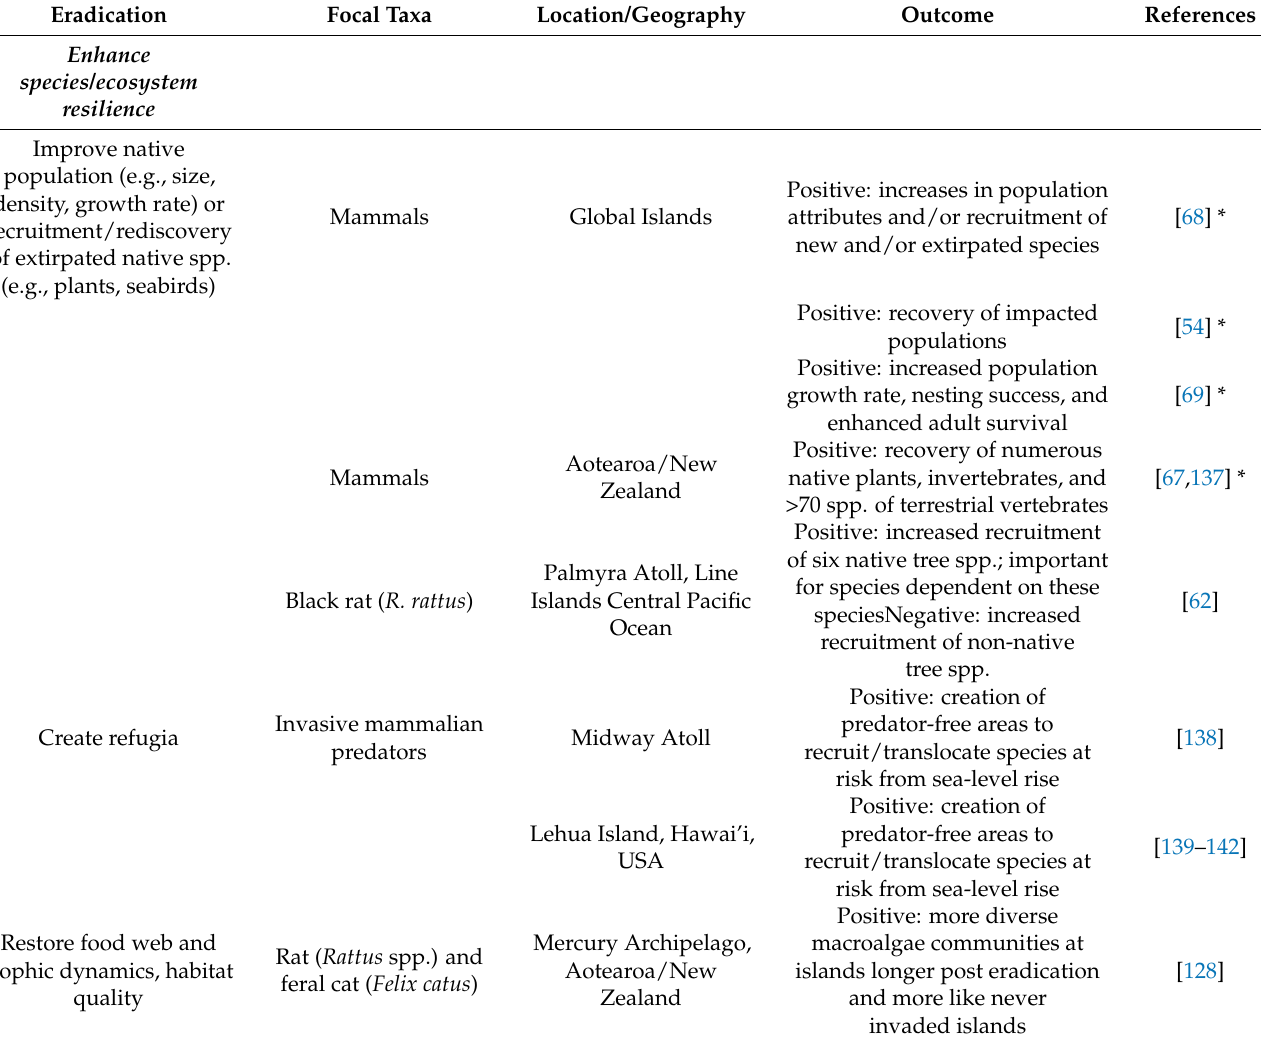
Table 3. Summary of evidence provided in the text that eradicating invasive mammals from islands may benefit climate change adaptation/resilience to or mitigation of climate change. This includes studies comparing islands with and without IAS. “Eradication” refers to the process promoted by eradicating invasive mammals. “Focal Taxa” refers to the taxa eradicated or compared with and without. “Location/Geography” refers to the study site. “Outcome” refers to the way in which the eradication or absence of IAS contributes to a climate adaptation/resiliency or mitigation outcome.